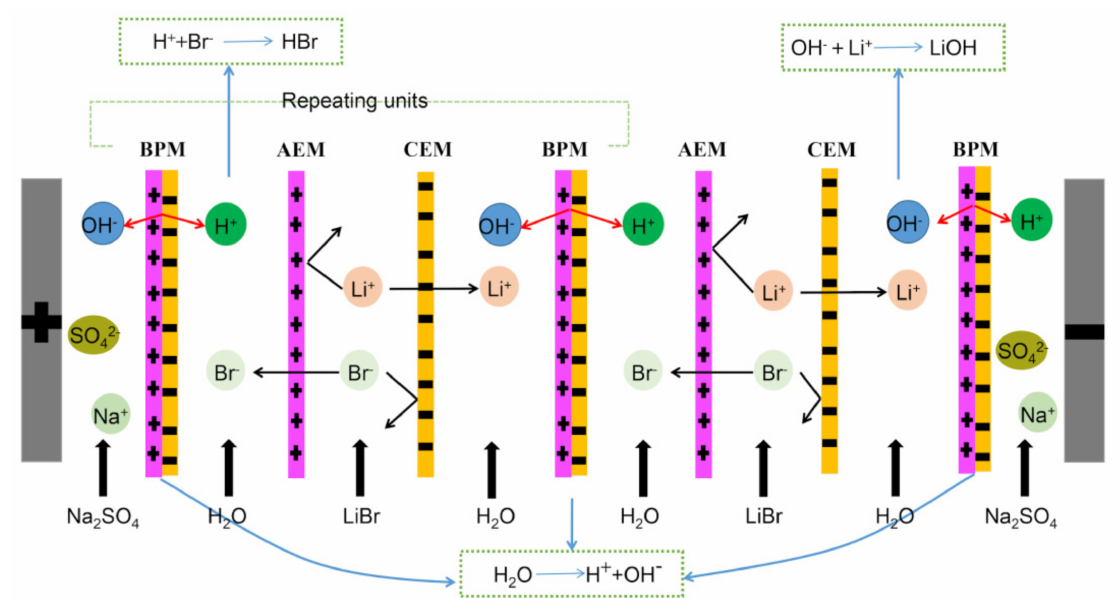
Figure 2. Schematic representation of the BMED stack used in the